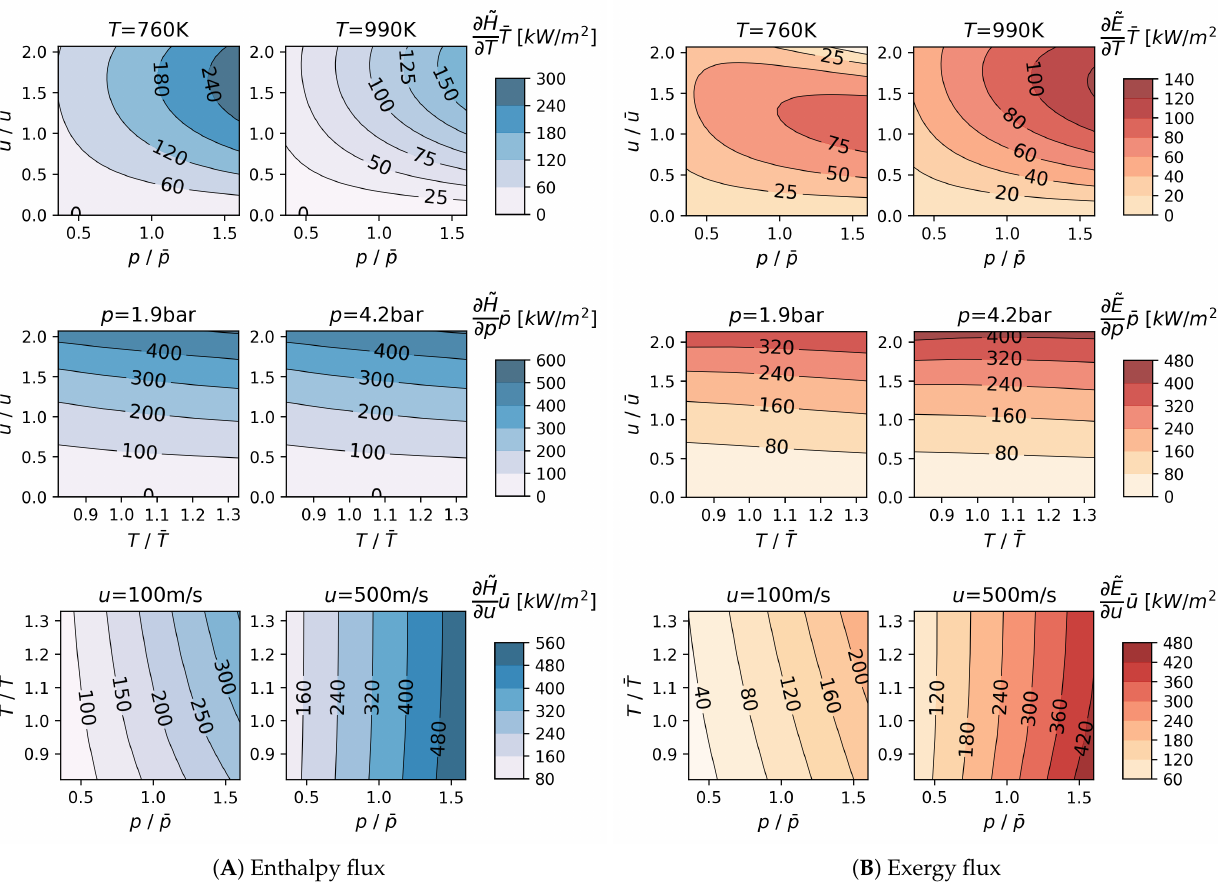
Figure 9. Gradient-based sensitivity of enthalpy and exergy flux (kW/m 2 ) with respect to flow parameters. The normaliza- tion of flow parameters was performed by taking the mean values as: ¯ T = 790 K, ¯ p = 2.5 bar (abs.), and ¯ u = 310